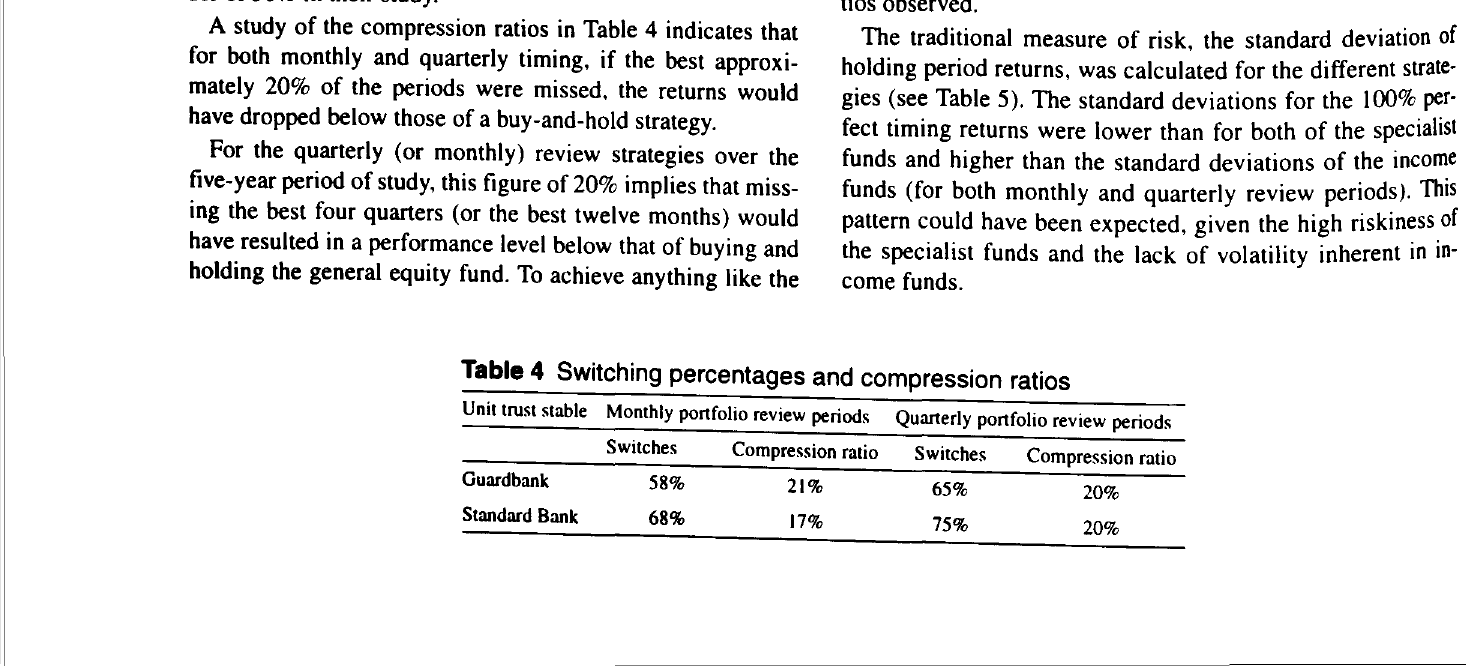
Table 4 Switching percentages and compression